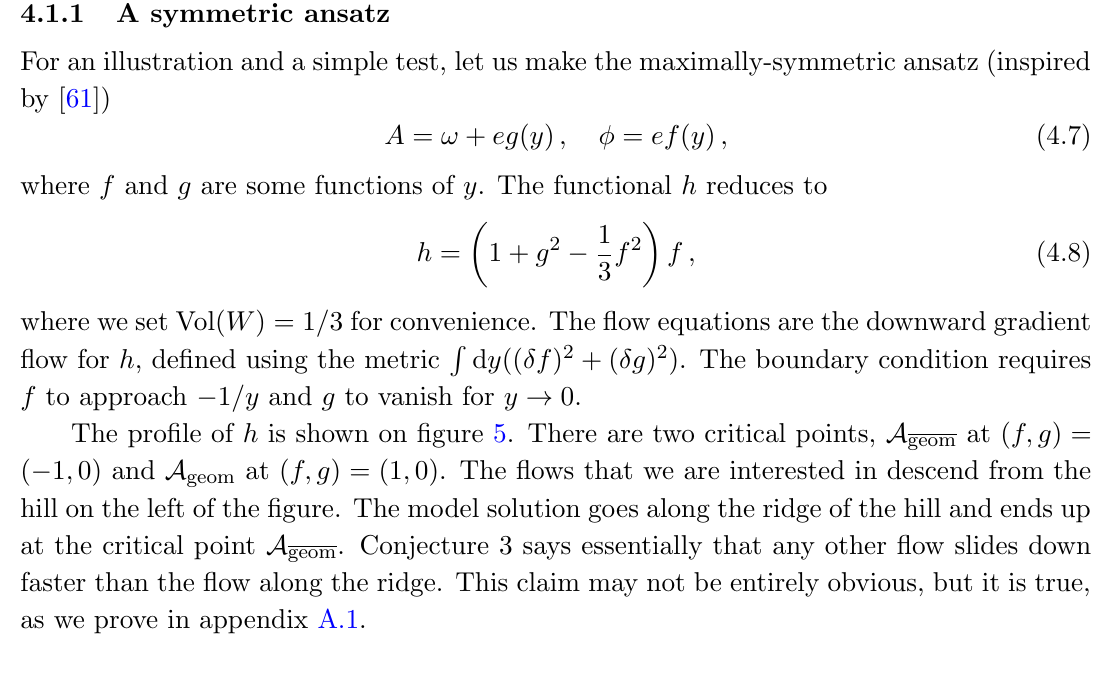
JHEP04(2018)085